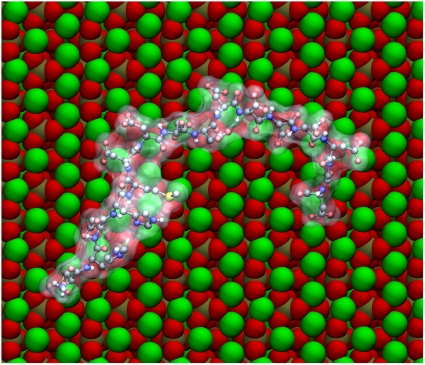
Orientation of pOPAR on the {100} face of HA.Peptide is viewed at the end of the 5-ns simulation. Crystal: Ca – green, O – red, P – orange. Peptide: C – grey, H – white, O – pink, N – purple, P – orange, S – yellow.